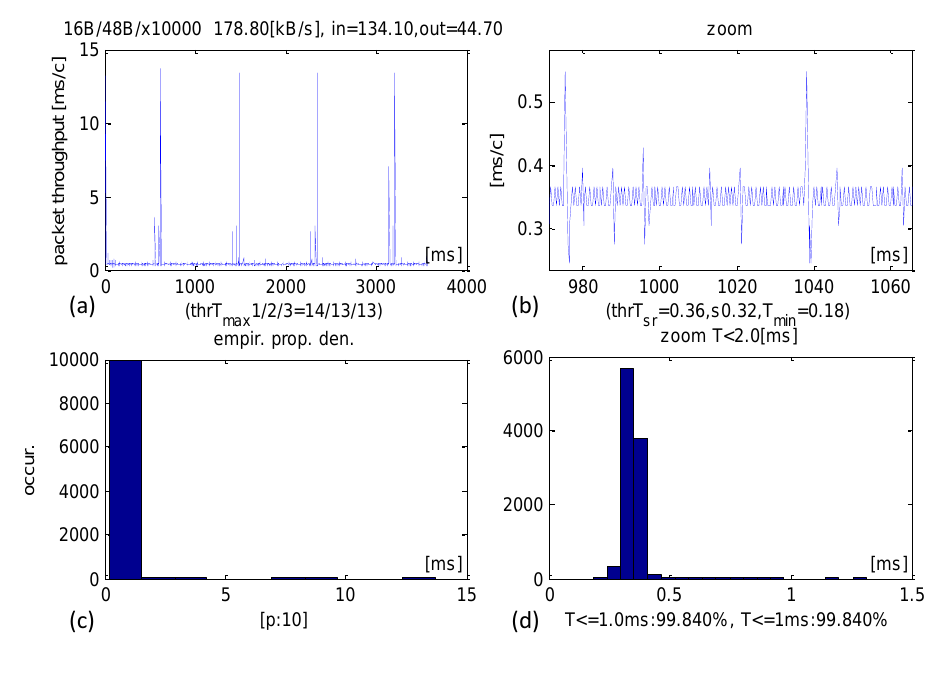
Figure 13. Experimental CCLT measured after the optimisation. Packet size IN = 48 B. ( a ) Recorded CCLTs. ( b ) Enlargement of selected section. ( c ) CCLT histogram. ( d ) Selective histogram